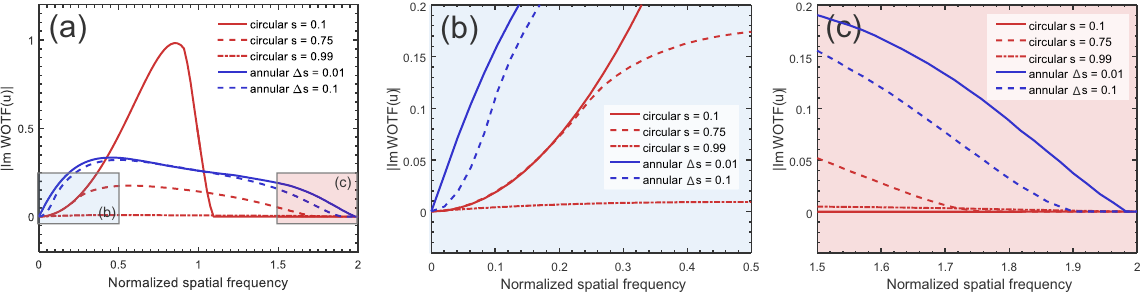
Figure 6. ( a ) Magnitudes of the phase WOTFs of the annular illuminations ( s = 0.01 and s = 0.1) and circular illuminations (s = 0.1, 0.75, 0.99) when the defocus distance is 0.5 μ m. For clarity, the two blue- and red-boxed regions are further enlarged in ( b ) and ( c ),